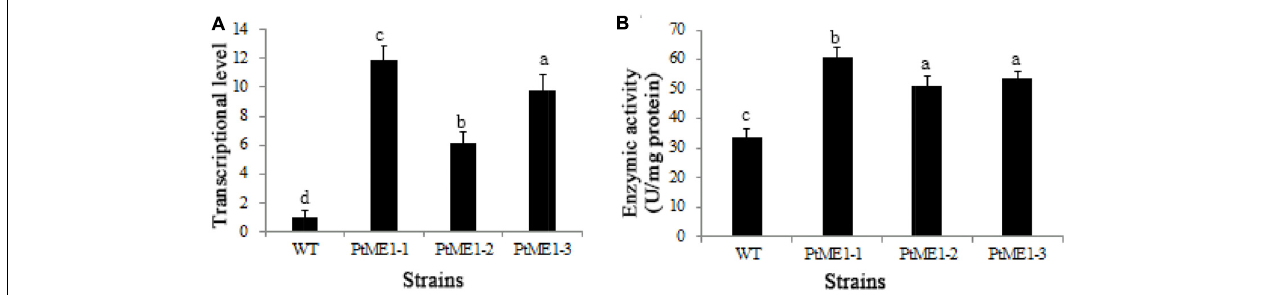
FIGURE 3 | Molecular characterization of resistant clones. (A) Relative quantification of ME1 transcripts in the WT strain and the three Phaeodactylum tricornutum resistant clones. ME1- transcript abundance in the resistant clones was quantified with WT cells as the standard and normalized to endogenous histone H4 expression ( n = 6). (B) NADP-ME activity (U/10 6 cells) in the WT strain and the three P. tricornutum transformants. Activity assays were performed on samples from the same experiments. Values represent averages of at least three replicates. Error bars indicate standard deviations. Values with different letters (a,b,c,d) indicate a significant difference between them ( p < 0.05).